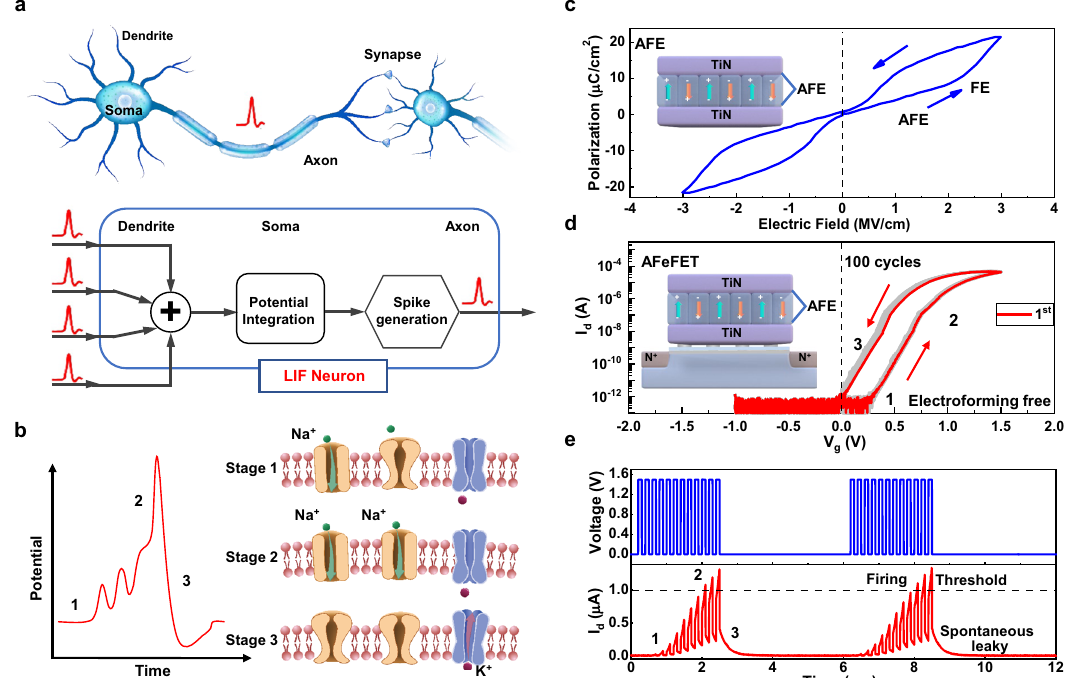
Fig. 1 | Leaky integrate-and- fi re dynamic of biological neuron vs AFeFET arti- fi cial neurons. a The architecture and processing model of biological neurons. External information is perceived by dendrites and then transmitted to the soma for processing. When the membrane potential surpasses a threshold value, an action potential can be generated and transmitted to post-neurons through the axon. b The integrate-and- fi re dynamics of a biological neuron. With the signal receivedbydendritesandtransmittedtosoma,fewNa + channelsareactivated,and the membrane potential goes up gradually (stage 1). As further signal is received, moreNa + channelsareactivatedquickly,andalargeamountofNa + fl owsinsidethe